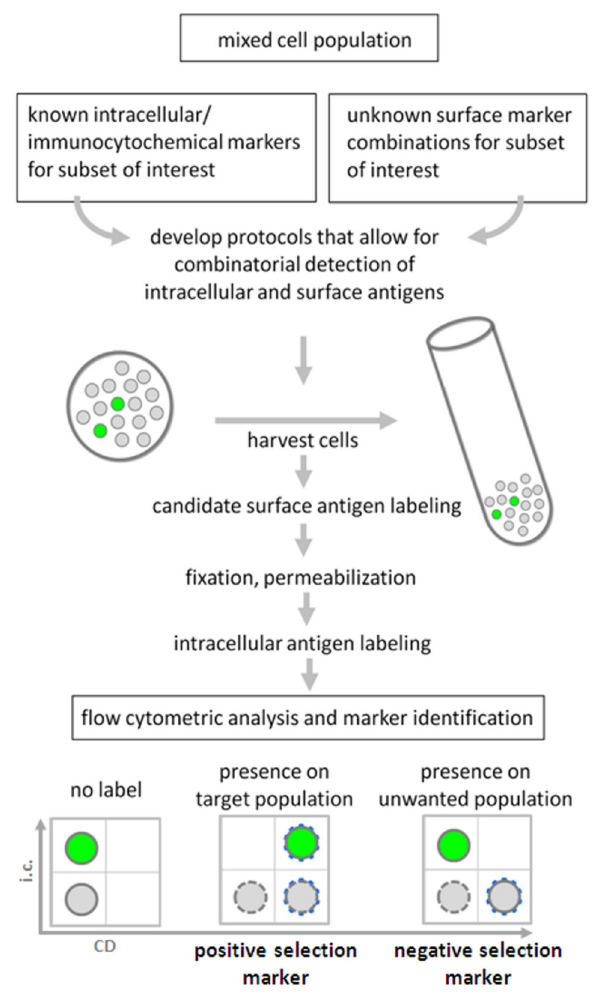
Figure 1. Experimental outline. Schematic illustrating the research strategy of identifying novel surface marker combinations on a target population in neural and other stem cell differentiation systems for which intracellular, standard immunocytochemical markers are well established. Following harvesting, the resulting single cell suspension is subject to surface antigen candidate staining, followed by gentle fixation, permeabilization and subsequent co-staining with known intracellular markers. CD markers co-labeling the target population serve as positive markers, those absent on the target population serve as negative markers. In a separate, subsequent step, a combination of the identified positive and/or negative CD markers enables the flow cytometric enrichment of the viable population of interest from a heterogeneous cell suspension for further study and biomedical